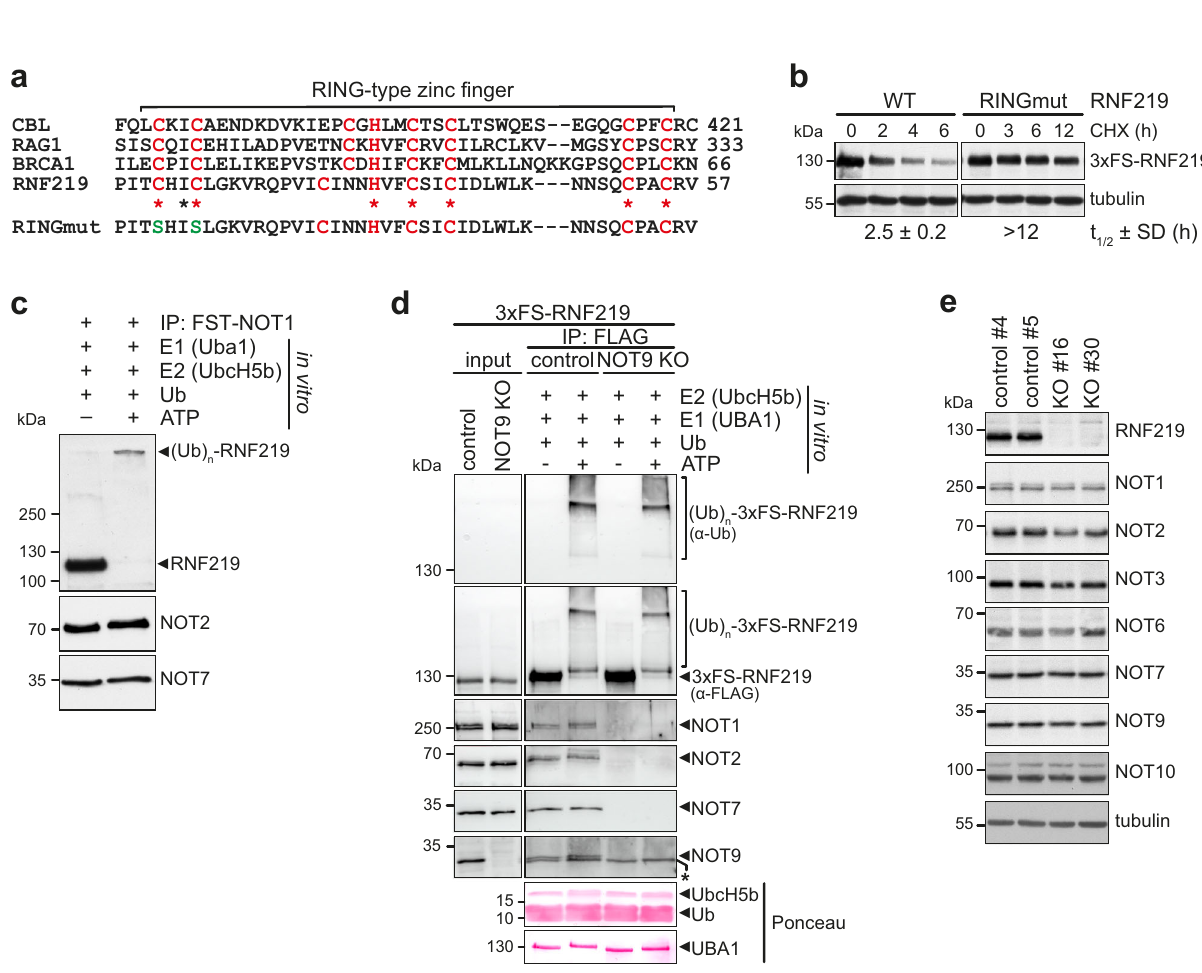
Fig. 2 RNF219 associates with the CCR4-NOT complex via NOT9. a Schematic illustration of the domain architecture of RNF219; RING, really interesting new gene; SLiM, short linear motif. RNF219-C (amino acid residues 434 – 726) and RNF219- Δ SLiM are shown below. b Co-precipitation of RNF219 was examined by FLAG IP of the endogenous CCR4-NOT complex from FST-NOT1 HeLa cells following transfection with either control or NOT9-targeting siRNAs for 48 h. Proteins were analyzed by western blotting with antibodies as indicated; the asterisks denote non-speci fi c bands. c Coomassie-stained polyacrylamide gel of in vitro pull-down assays with recombinant RNF219-C fused to maltose-binding protein (MBP) and a StrepII (Strep) af fi nity tag upon incubation with four different CCR4-NOT modules as indicated. d Co-IP of endogenous NOT2 and NOT9 with RNF219 using HeLa cells stably expressing 3xFLAG-SBP (3xFS)-RNF219-WT or 3xFS-RNF219- Δ SLiM. Precipitated proteins were detected by western blot analysis using antibodies as indicated. e Co- sedimentation analysis of CCR4-NOT subunits by 10 – 30% linear glycerol gradient fractionation and western blotting from HeLa cells stably expressing 3xFS-RNF219-WT or 3xFS-RNF219- Δ SLiM. The core CCR4-NOT complex elutes in fractions 7 – 14. Data from one representative experiment are shown (left panel), and the relative distribution of RNF219 and NOT7 along the gradient was quanti fi ed (right panel); values are presented as mean ± SD (WT n = 3; Δ SLiM n = 4; fraction 8, p = 0.0313; fraction 9, p = 0.0154; fraction 14, p = 0.0106). The asterisks denote non-speci fi c bands. p values were calculated using a two-tailed, paired t test (* p < 0.05). Source data for panels ( b – e ) are provided as a Source Data fi le.